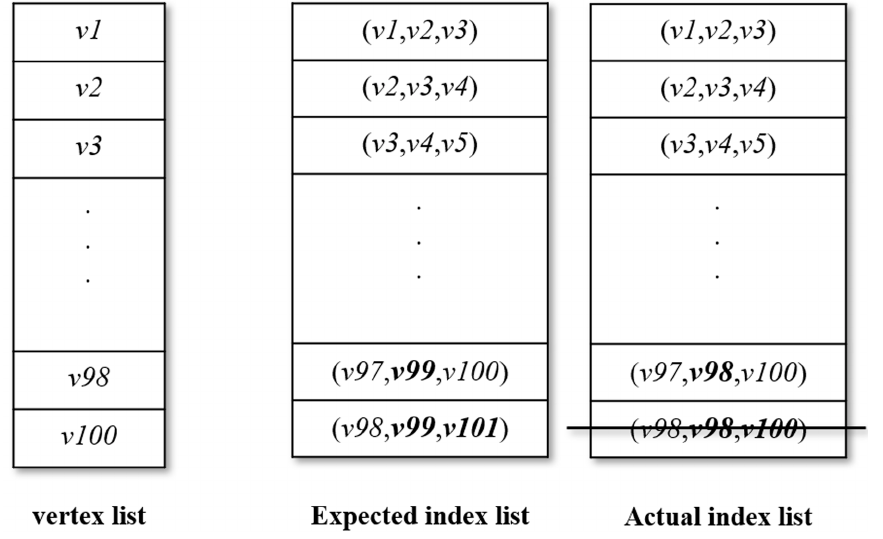
Figure 8. Update actual index list based on vertex list and expected index